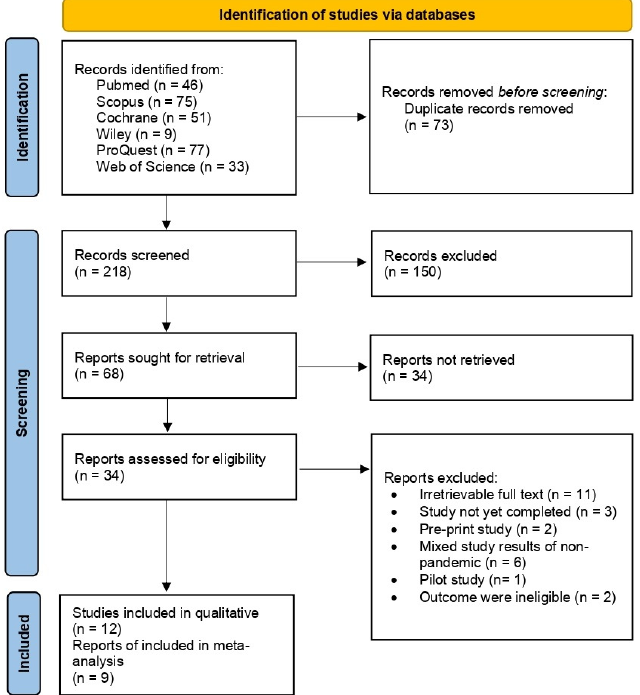
Figure 1. PRISMA flow diagram .